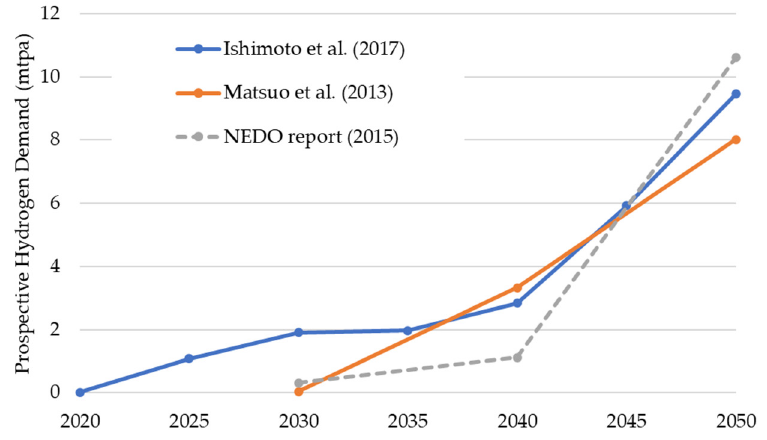
Figure 2. Projected growth in Japanese hydrogen demand according to several studies (after [21]).